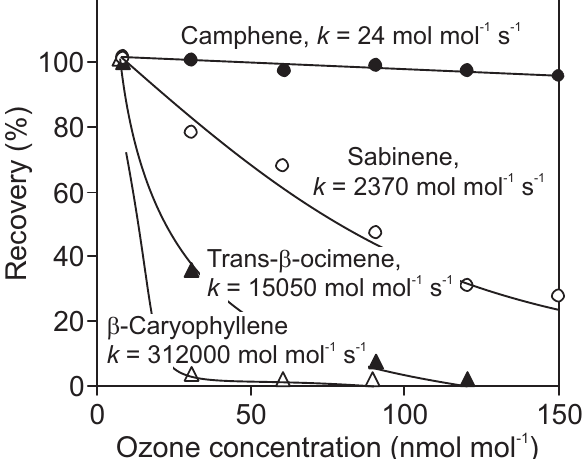
Fig. 4. Comparison of the recovery of terpenes with various reactiv- ity sampled on polymeric adsorbent Tenax TA in atmospheres with varying ozone concentration (data from Calogirou et al., 1996). The reactivity of different terpenes is characterized by the atmospheric reaction rate constant for ozone ( k ). The reaction rate constants as compiled in Calogirou et al.